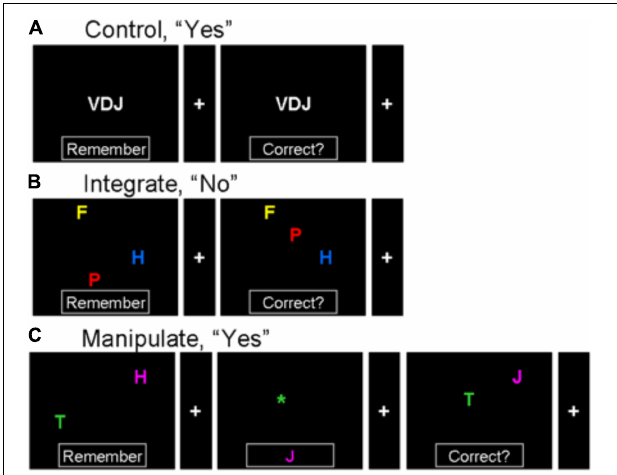
FIGURE 1 | Illustration of three kinds of cognitive tasks. Stimuli in the initial sample screen are encoded, and compared to a final probe, with an intervening “change cue” in the manipulate trials. (A) Sample then probe in control condition (with only letter identity maintenance); correct answer is “yes” since the letters in the sample are the same as the letters in the probe. (B) Integrate condition with maintenance of integrated letter identity, spatial and color information; a “no” trial since the identity, position, and color are not the same for each of the three letters in both sample and probe. (C) Sample, change cue, and probe in a manipulate condition trial requiring manipulation of integrated letter identity, spatial and color information; a “yes” trial. The two letters in the sample are encoded, and at the change cue the internal representation is altered so that the letter in the same color as the asterisk (green in this trial) is moved to the position of the asterisk, and the identity of the letter whose color matches the letter in the box is changed to match the letter in the box. This changed mental representation is compared to the final